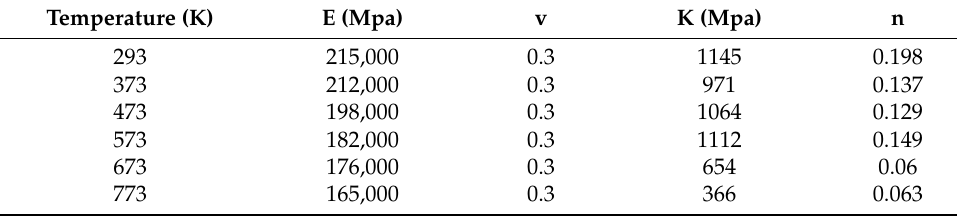
Table 2. Elastoplastic mechanical parameters.